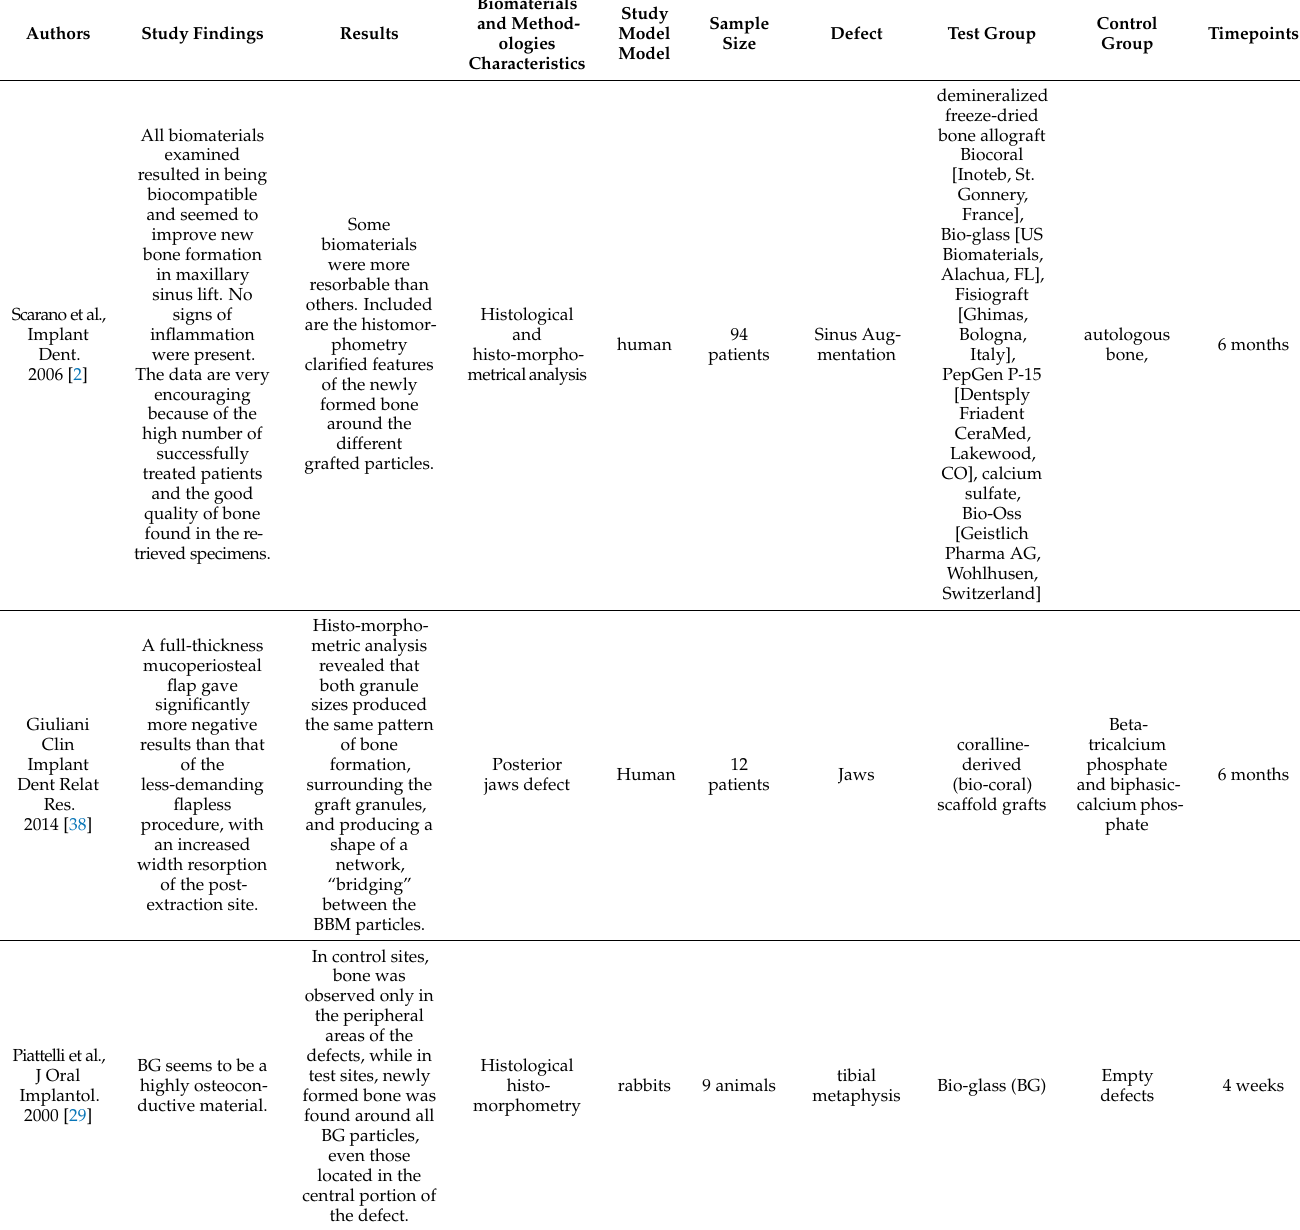
Table 6. Summary table of the Bio-glass findings of the papers